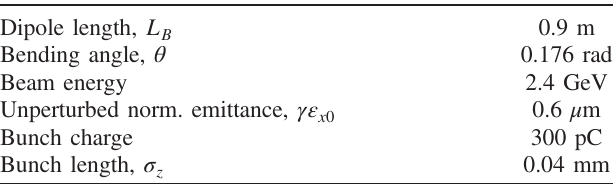
TABLE I. Selected parameters for the ELEGANT simulation.